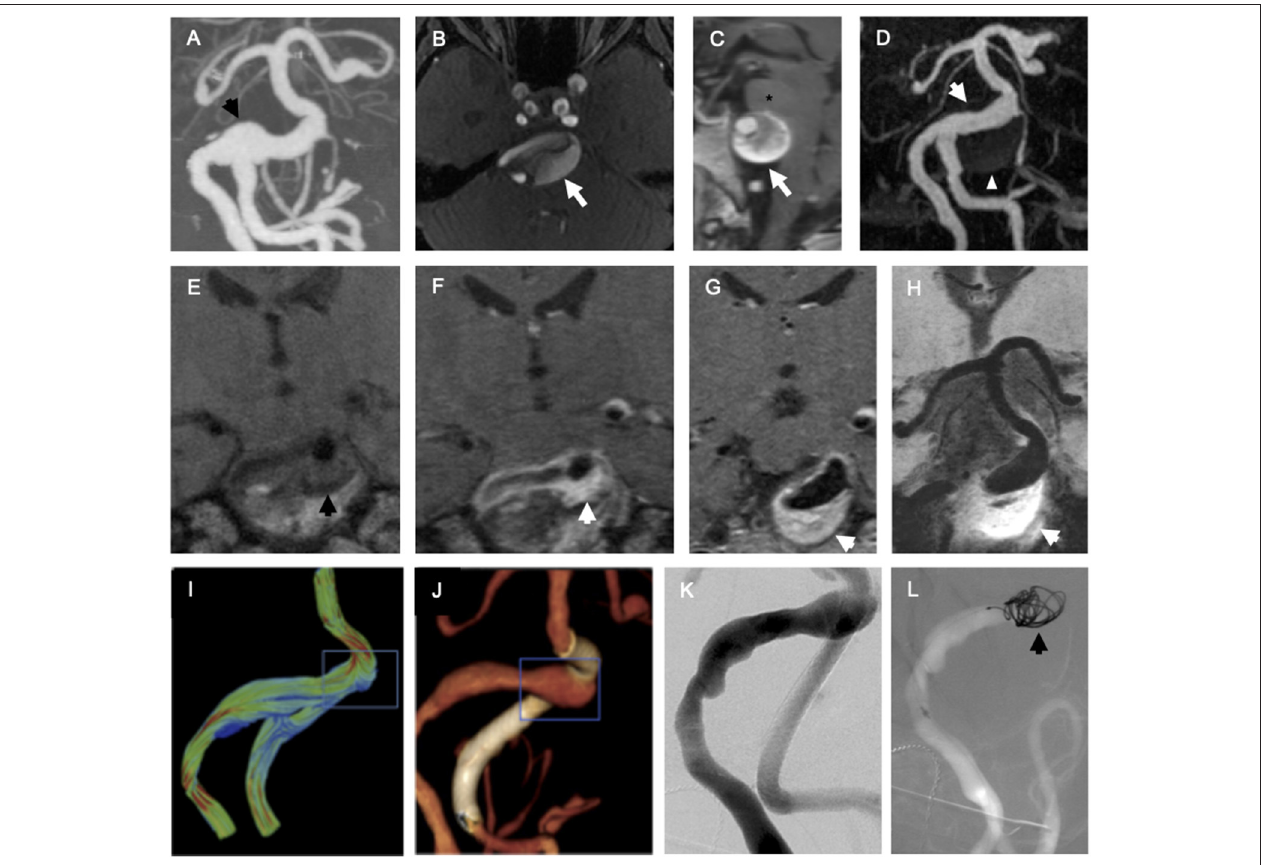
FIGURE 1 | Endovascular biopsy of endothelial cells (ECs) from fusiform vertebrobasilar aneurysm. (A) Coronal maximum intensity projection (MIP) reformat of CT angiogram of the head focusing on the posterior intracranial circulation demonstrates fusiform vertebrobasilar aneurysm with focal dilation of the right vertebrobasilar junction (black arrow). (B) Axial time-of-flight magnetic resonance (MR) angiogram of the head demonstrates fusiform aneurysm involves the basilar artery (white arrow). (C) Sagittal T1-weighted MRI of the brain demonstrates fusiform aneurysm involving the basilar artery (white arrow) compresses the pons of the brainstem (asterisk). (D) Coronal MIP reformat of contrast-enhanced magnetic resonance angiography (MRA) demonstrates fusiform aneurysm involves the basilar artery (white arrow) and the partially thrombosed aneurysm wall is much larger than the white lumen (white arrowhead). Coronal T1-weighted MRI of the right vertebrobasilar junction before (E) and after (F) administration of gadolinium chelate contrast demonstrates intense enhancement of the aneurysm wall, suggestive of non-specific inflammation (black arrow = aneurysm wall before contrast and white arrow = aneurysm wall after contrast). (G,H) Hyperenhancement of the aneurysm wall (white arrow) is seen at the right vertebrobasilar junction on 0.6mm slice thickness (G) and 10mm minIP reformat (H) images. (I) A computational fluid dynamic model derived from angiographic data demonstrates high velocity vectors at the superior aspect of the vertebrobasilar junction (blue box). (J) Three-dimensional volume-rendered reformat of flat panel CT angiogram demonstrates focal dilation of the right vertebrobasilar junction (blue box) and flow-diverting stent in the left intradural vertebral artery (white). (K) Planar right vertebral arteriogram in left anterior oblique projection. (L) Roadmap right vertebral arteriogram in the same projection shows a platinum coil (black arrow) in contact with the endothelium of the right vertebrobasilar junction during endovascular